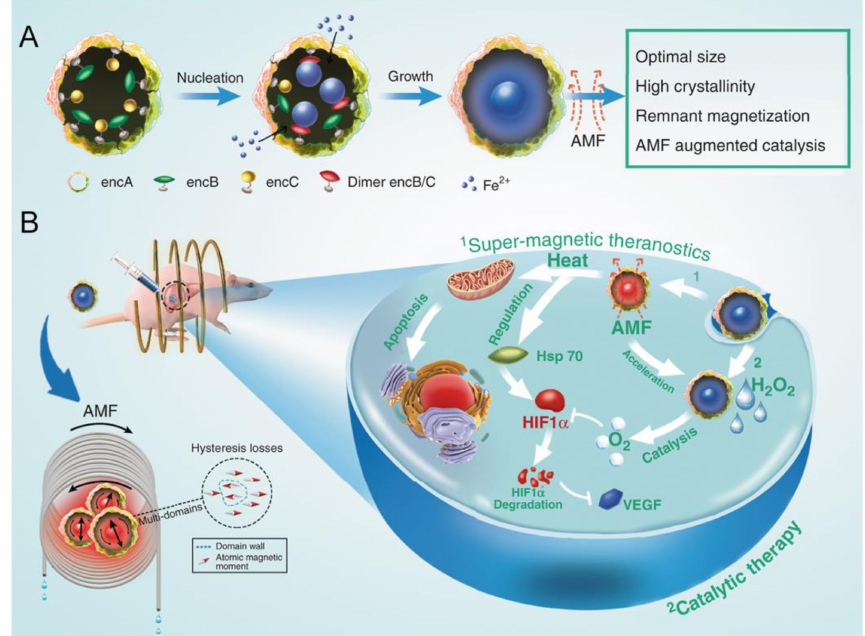
Figure 7. Engineering of encapsulin-produced magnetic iron oxide nanoparticles (eMIONs) for magneto-catalytic therapy. ( A ) Production of eMIONs by the in vitro biomineralization of EncMx containing EncB and EncC cargo proteins. ( B ) eMIONs accumulated in tumors suppressed tu- mor growth. In the presence of an alternative magnetic field (AMF), eMIONs induce magnetic hyperthermia (left arrow) and have enhanced catalase-like activity (right arrow). Reprinted from